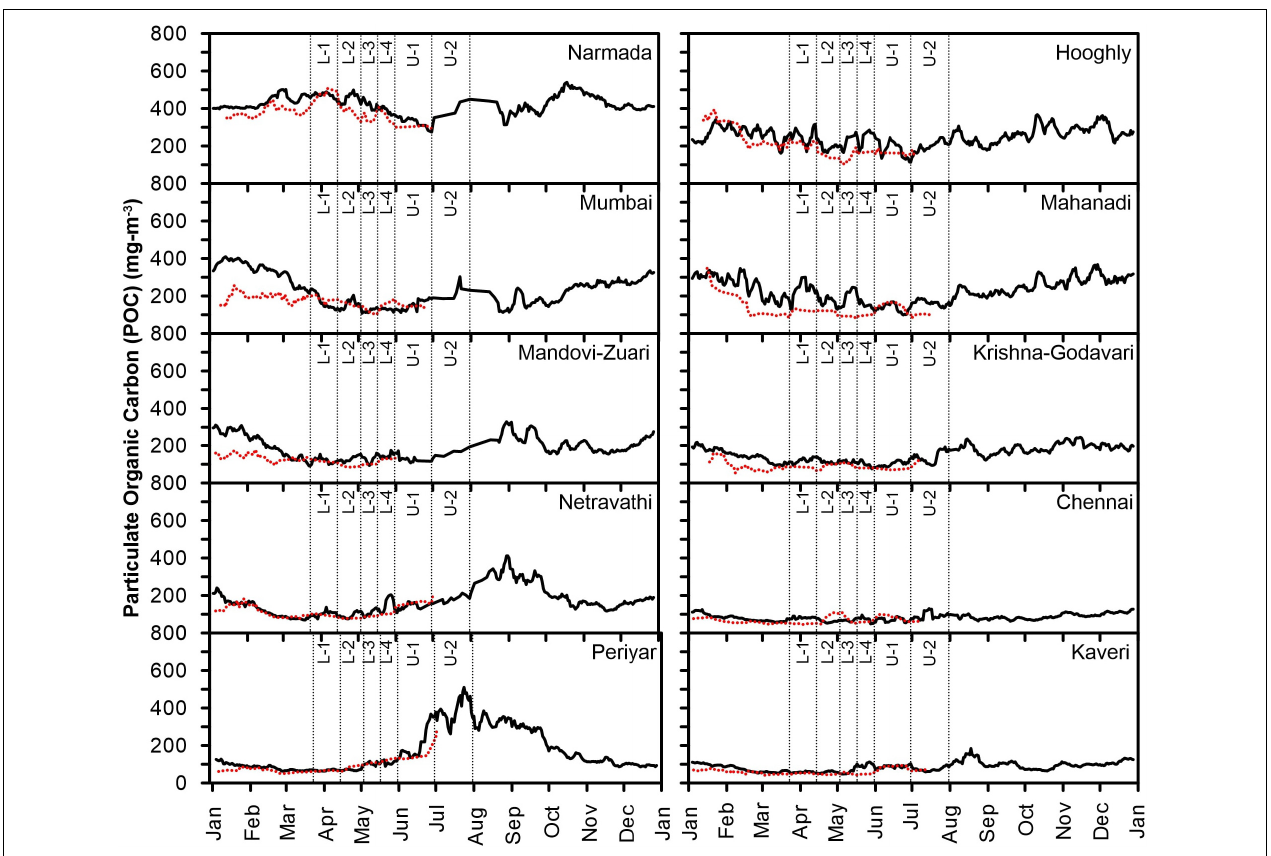
FIGURE 5 | Mean time-series variability in POC climatology (solid black line) and for the year 2020 (dotted red line) off major Indian cities and river